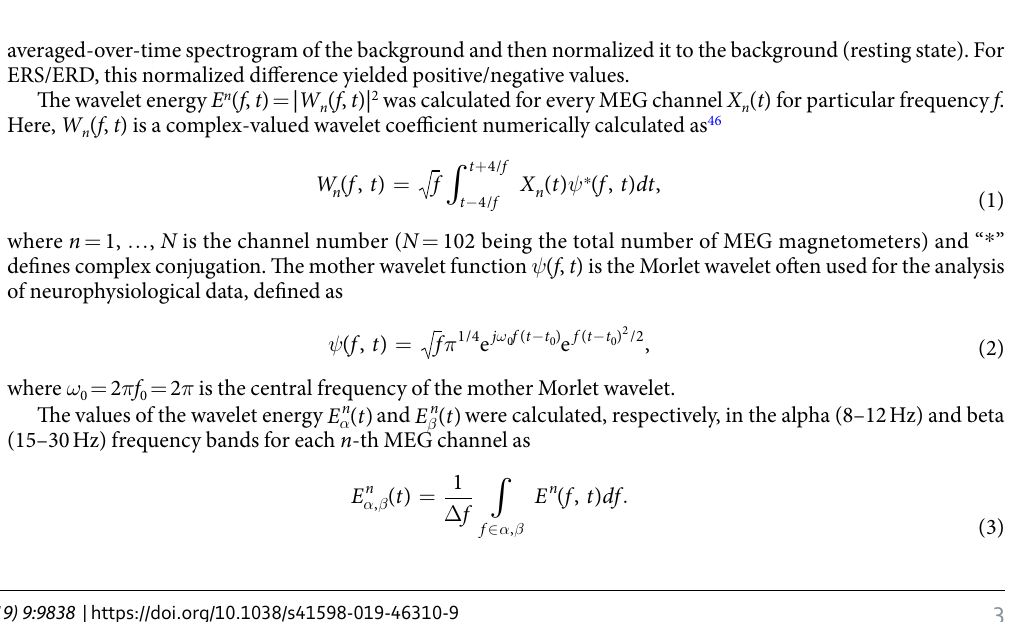
Figure 1. Design of the MEG experiment on motor imagery (MI). ( A ) Schematic representation of experimental performance and ( B ) experimental algorithm. RMI i and LMI i are time intervals corresponding to right-arm and left-arm MI, respectively, i indicates the subsequent trial number, and Δ t denotes the duration of each